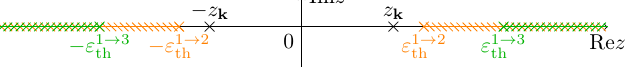
Figure 2: Analytic structure of the self-energy Σ ( k , z ) on the real axis. The two branch cuts on the positive real axis represent the real quasiparticle decay processes (orange stripes: the process γ → γ + b associated to the bosonic continuum [ ε 1 → 2 , + ∞ [ , th green stripes: the process γ → γ + γ + γ associated to the fermionic continuum [ ε 1 → 3 , + ∞ [ , in terms the fermionic quasiparticle γ and a bosonic collective mode th b ). Below those thresholds, a real solution z of (2) may exists depending on the k value of k . The two branches on the negative real axis represent the far-off-shell virtual processes (orange stripes: the process (cid:59) → γ + γ + b , green stripes: the process (cid:59) → γ + γ + γ + γ